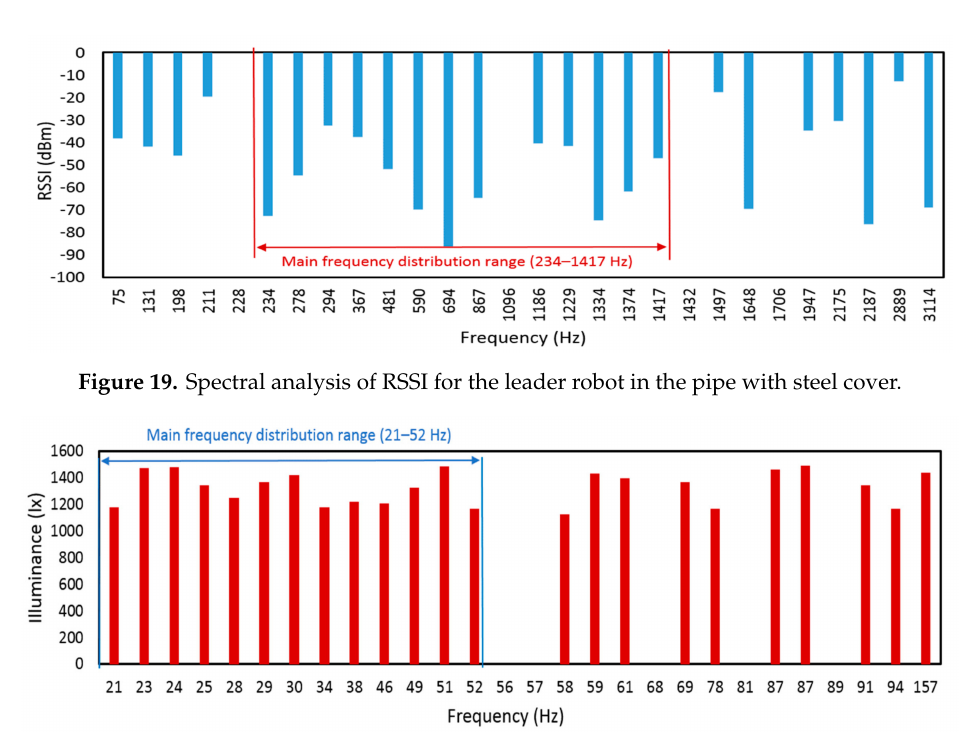
Figure 20. Spectral analysis of illuminance for the leader robot in the pipe with steel